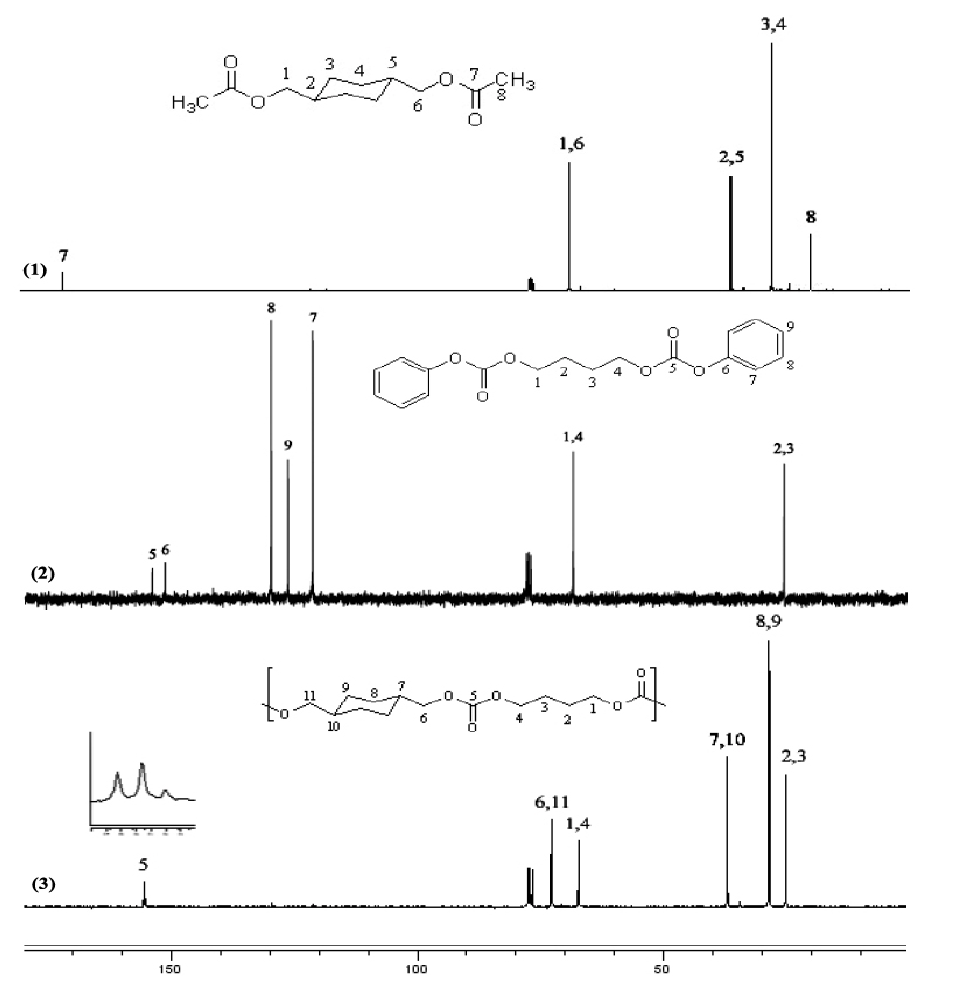
Figure 3. 13 C-NMR spectra of: (1) CHDMAc2 (2) BuD DPDC (3) CHDM-BuD polycarbonate (Series